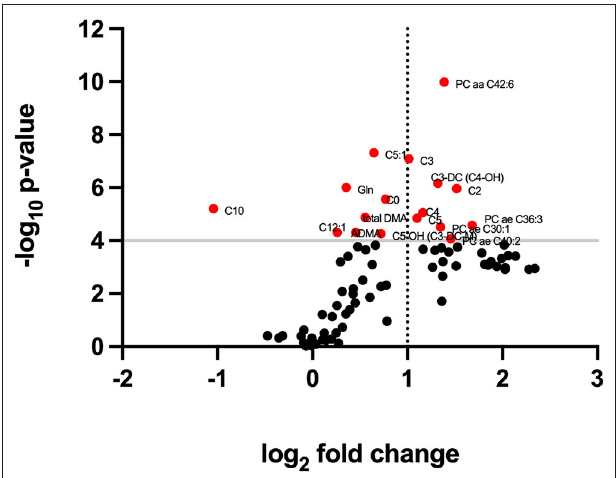
FIGURE 1 | Volcano plot relating significance levels and fold change in data from glaucoma and control samples. Compounds for which differences have a p < 0.0001 score are shown in